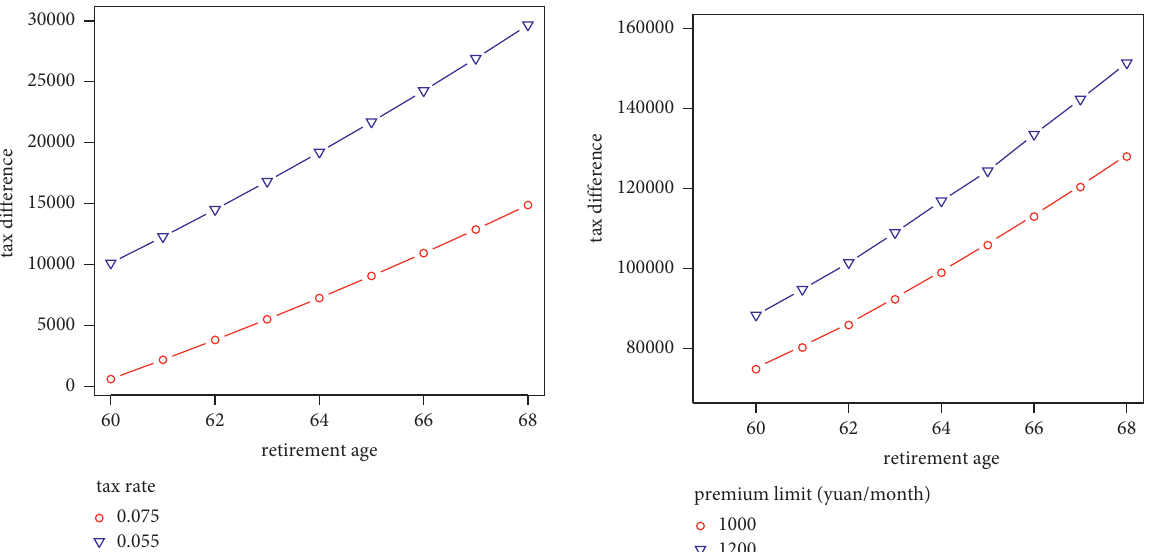
Figure 5: Tax difference under different retirement